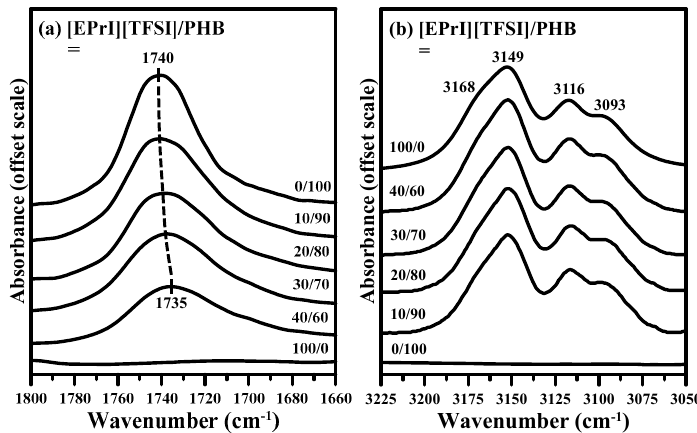
Figure 10. ( a ) Carbonyl stretching region in FTIR spectra of [EPrI][TFSI]/PHB blends; and ( b ) FTIR spectra in the C–H stretching vibrational region of imidazolium cation ring for [EPrI][TFSI]/PHB blends with different compositions.